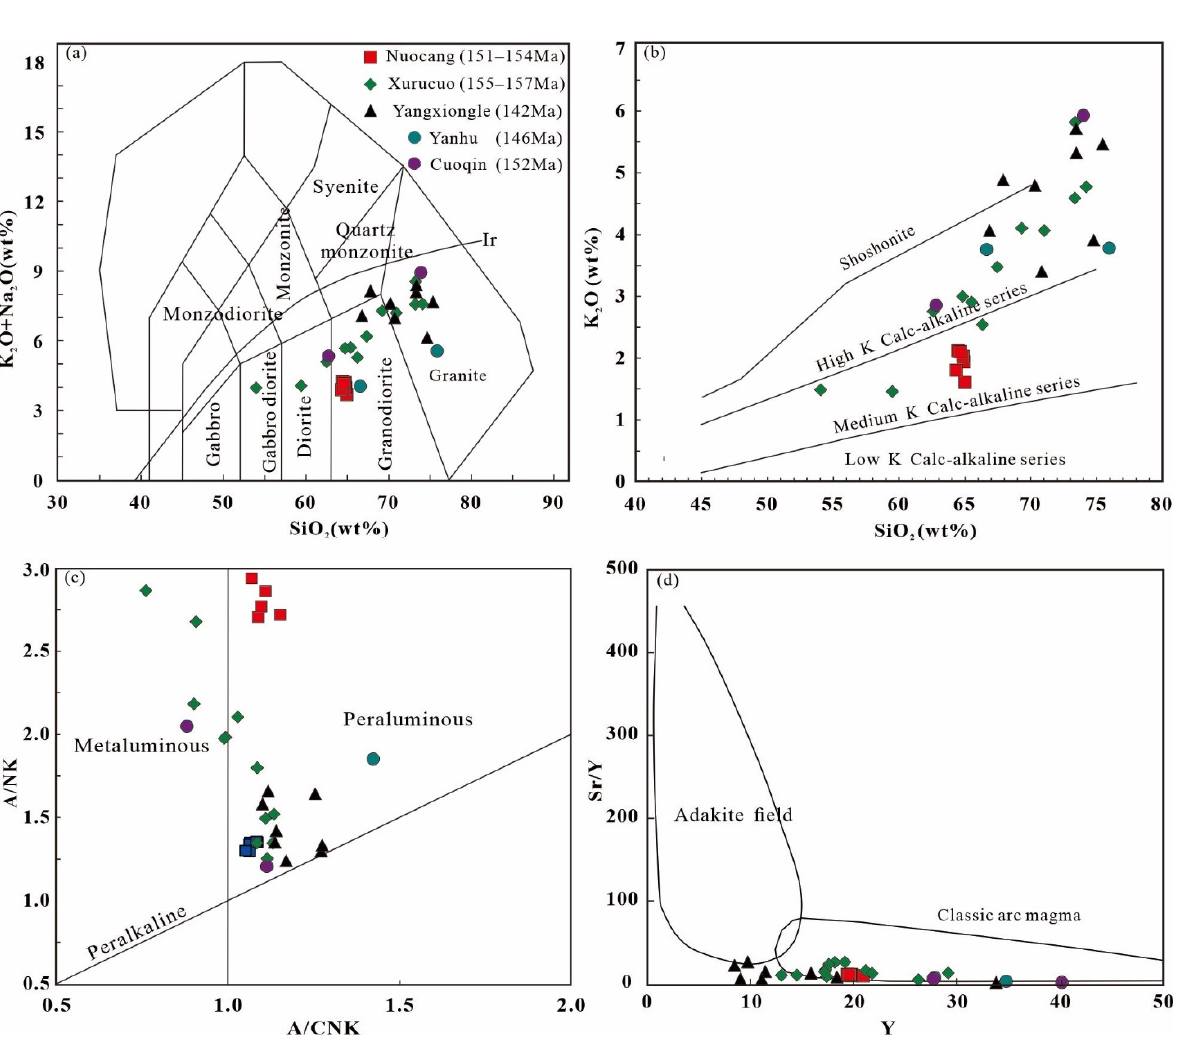
Figure 5. ( a ) K 2 O + Na 2 O vs. SiO 2 diagram [43]; ( b ) K 2 O vs. SiO 2 diagram [44]; ( c ) A/NK vs. A/CNK diagram [45]; ( d ) Sr/Y vs. Y diagram [45]. Data sources: Nuocang granodiorites from this study; Xurucuo granitoids [16]; Yangxiongle granitoids [23]; Yanhu and Cuoqin granitoids [4].